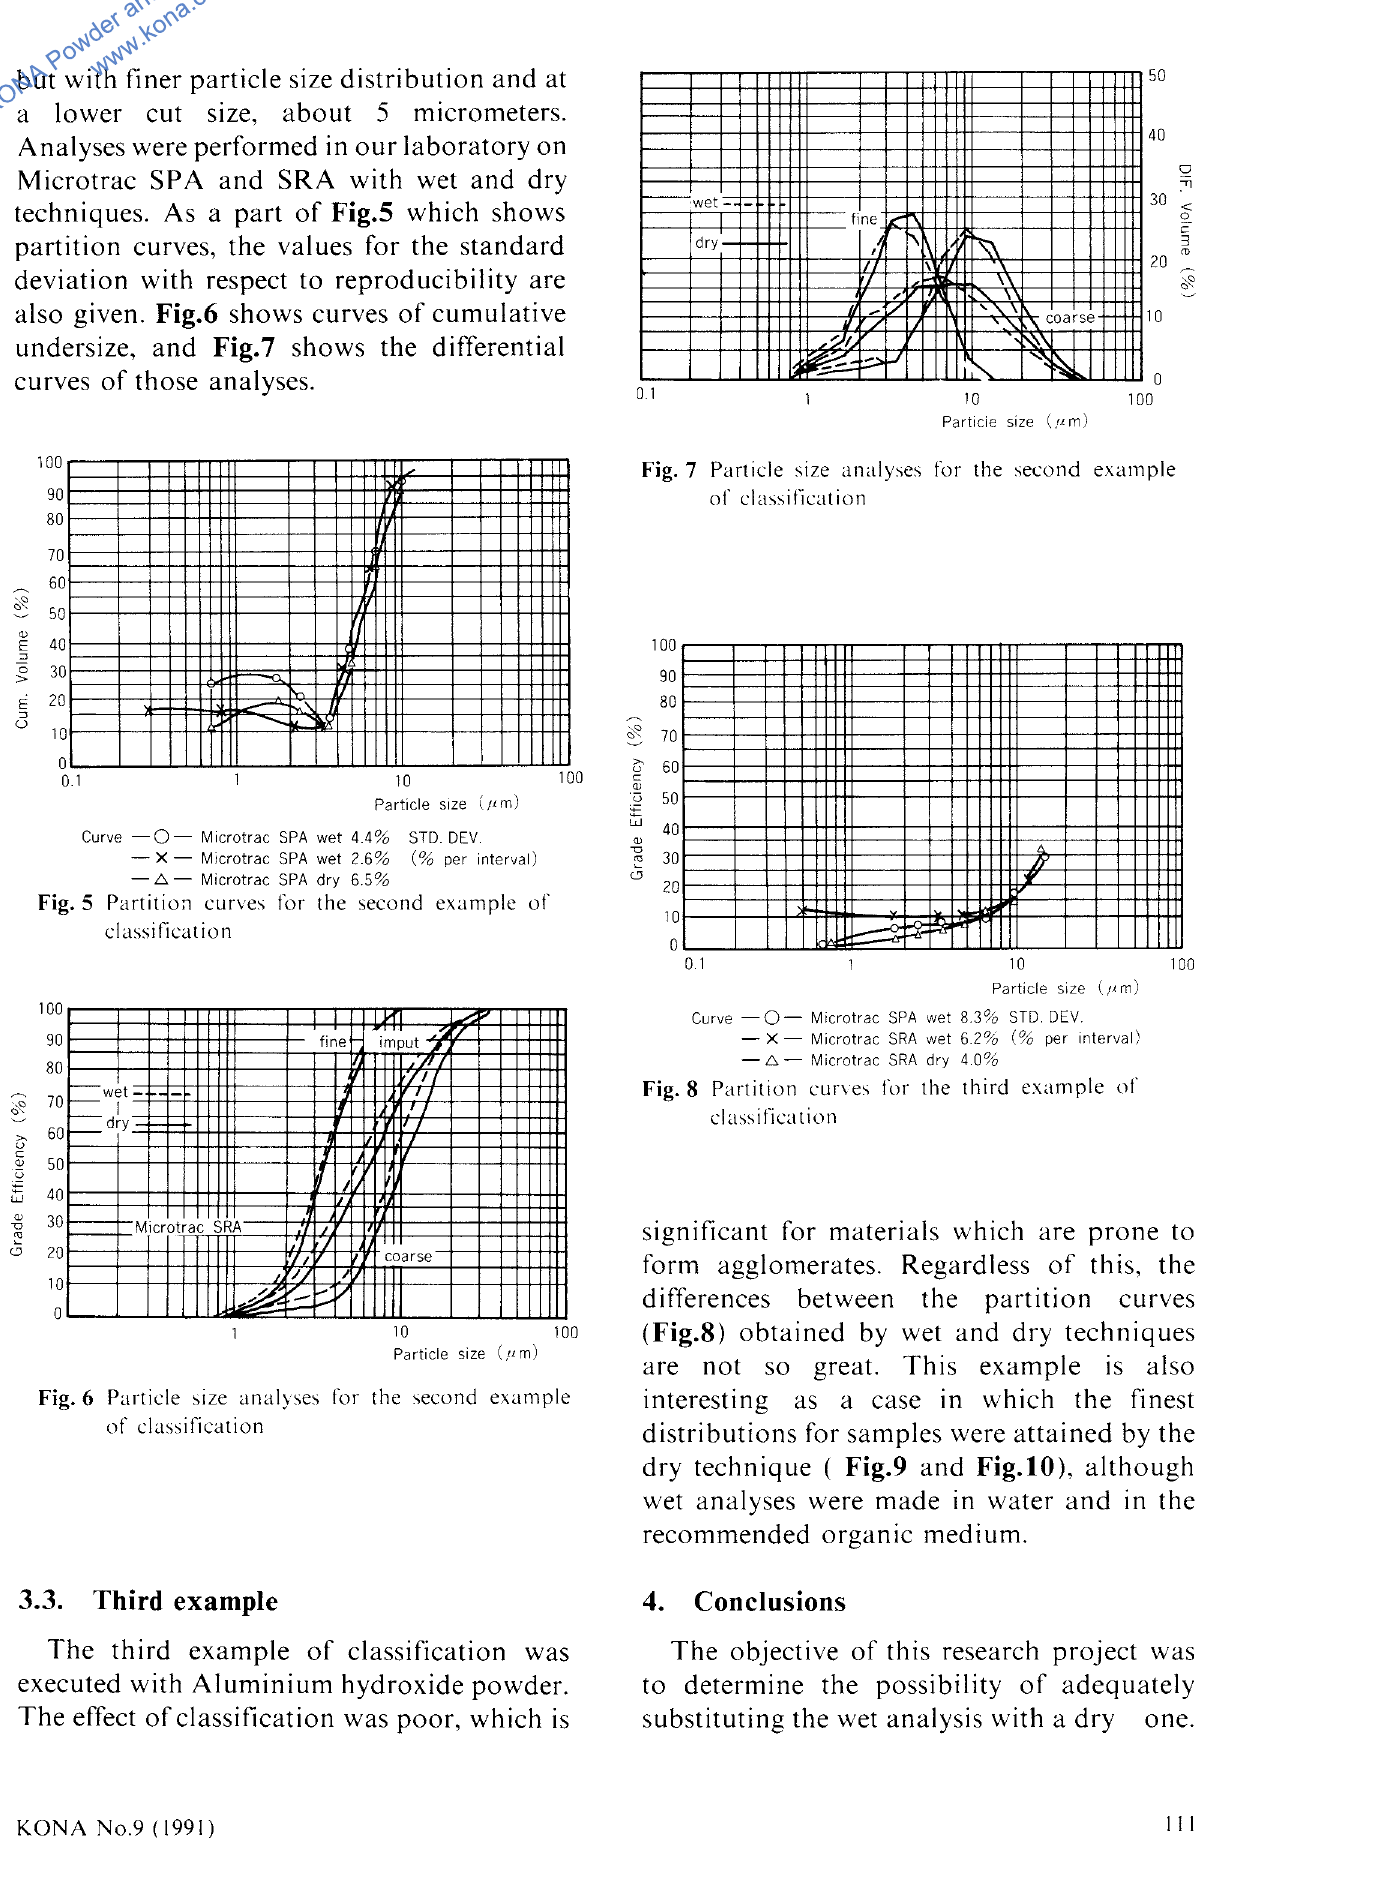
Fig. 6 Particle size anal) ses for the second example of classification